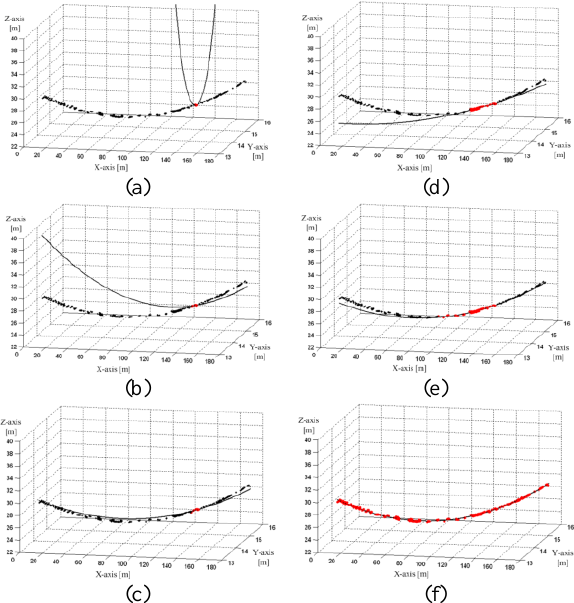
Figure 6. Optimal PL model generation (black coloured line) and its corresponding PL points (red coloured points); (a) initial PL model, (b) and (c) PL models from hypothesis-and-test, (d), (e), and (f) PL models from non-hypothesis-and-test, (f) final PL reconstruction.